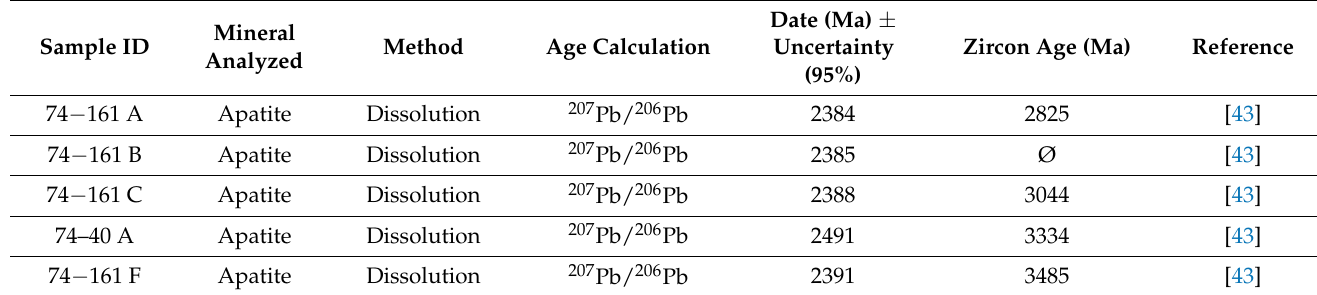
Table 3. U–Pb and Sm–Nd isotopes date of REE-rich minerals from the Saglek Block and of